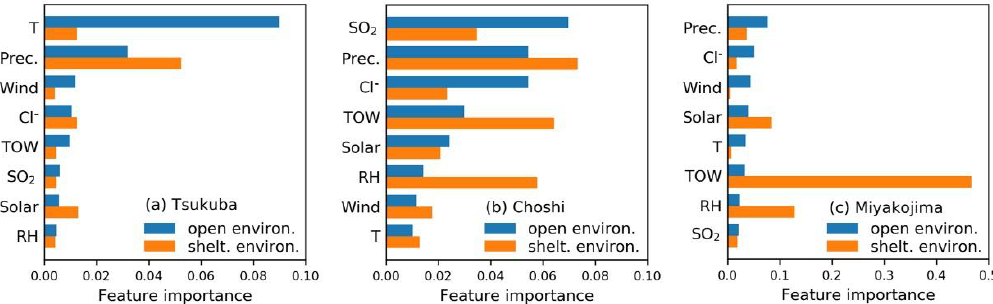
Figure 4. The environmental feature importance on the corrosion rate of steel samples under the open and sheltered environment at the exposure test site ( a ) Tsukuba, ( b ) Choshi, and ( c )